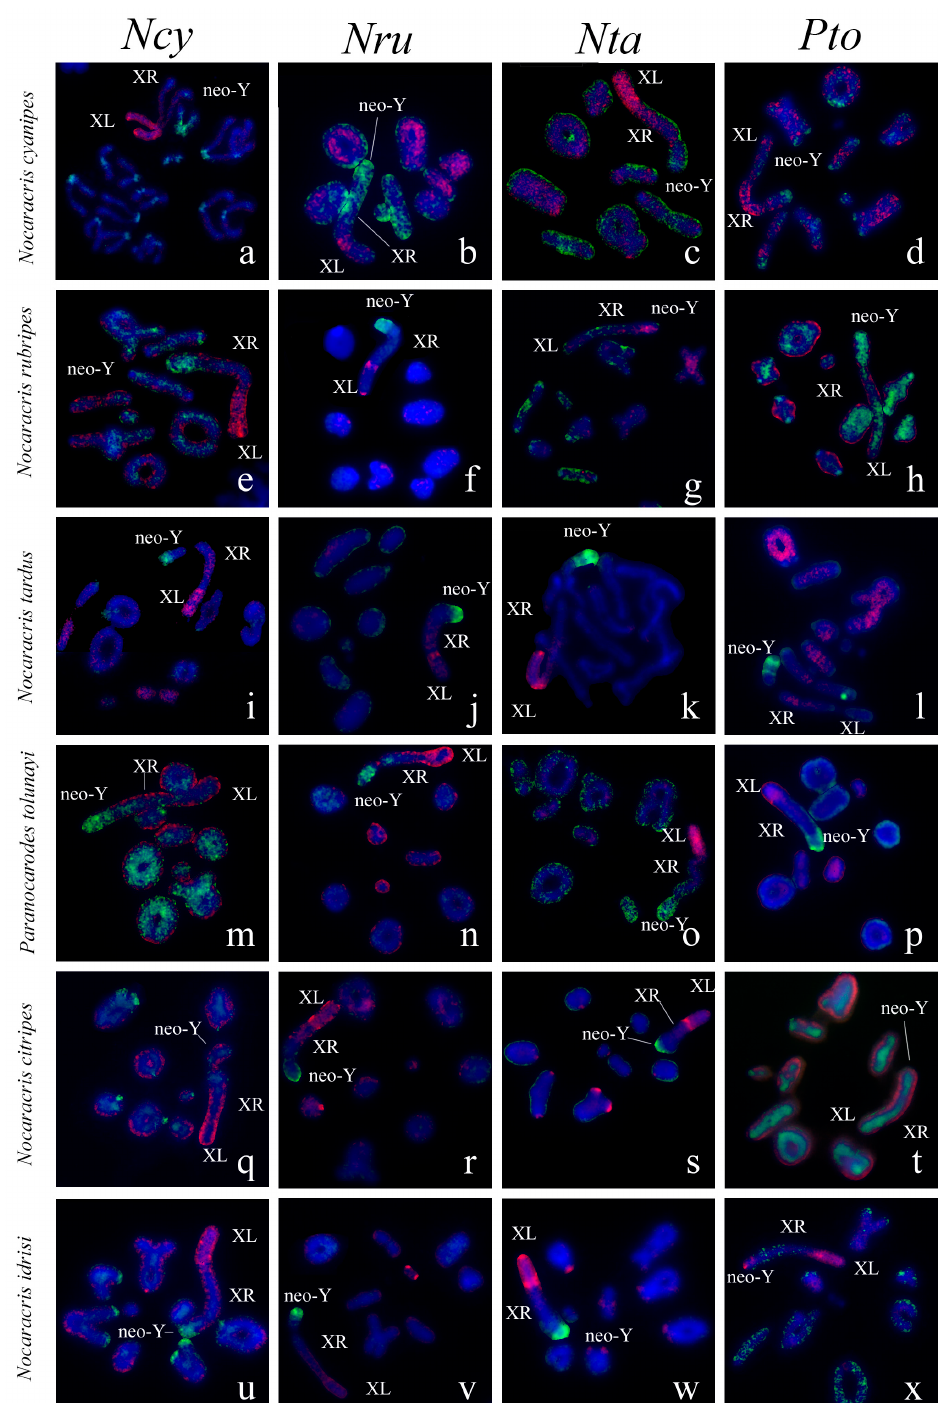
Figure 5. Results of the VISSIS analysis of the chromosome plates shown on the Figure 3. XL indicates short arm of neo-X that corresponds to ancestral X chromosome, XR indicates long arm of neo-X chromosome derived from autosome fusion. Neo-Y indicates corresponding chromosome. Names of species indicated in rows and name of probes indicated in columns. ( a – d ) Nocaracris cyanipes ; ( e – h ) Nocaracris rubripes ; ( i – l ) Nocaracris tardus; ( m – p ) Paranocarodes tolunayi tolunayi ; ( q – t ) Nocaracris citripes citripes; ( u – x ) Nocaracris idrisi .